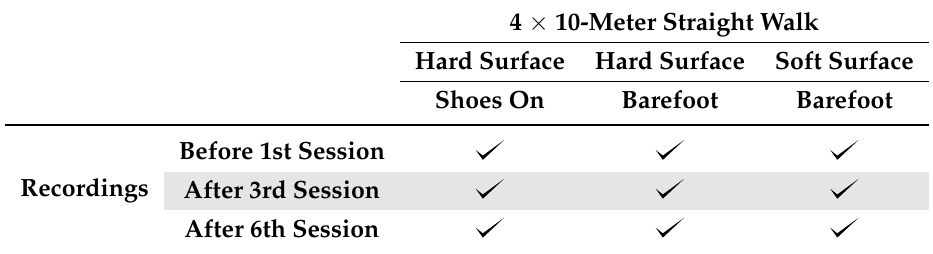
Table 2. Standardized gait tasks. Experiments were performed on different surfaces with and without shoes, as shown here. For each participant, 9 different recording sessions were carried out in